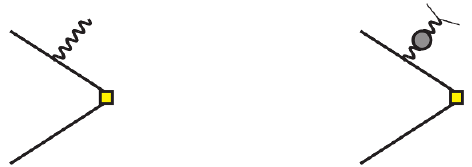
Figure 2 . Left: absorption or emission of an on-shell gauge boson by an annihilating dark matter particle. Right: t -channel scattering of a dark matter particle o(cid:11) thermal Standard Model particles, denoted by thin lines. The (cid:12)lled blob indicates that, due to infrared sensitivity, the soft gauge boson has to dressed by thermal corrections such as Debye screening. The process on the right dominates in the range of eq. (4.6), whereas the process on the left dominates at low temperatures (cf. section